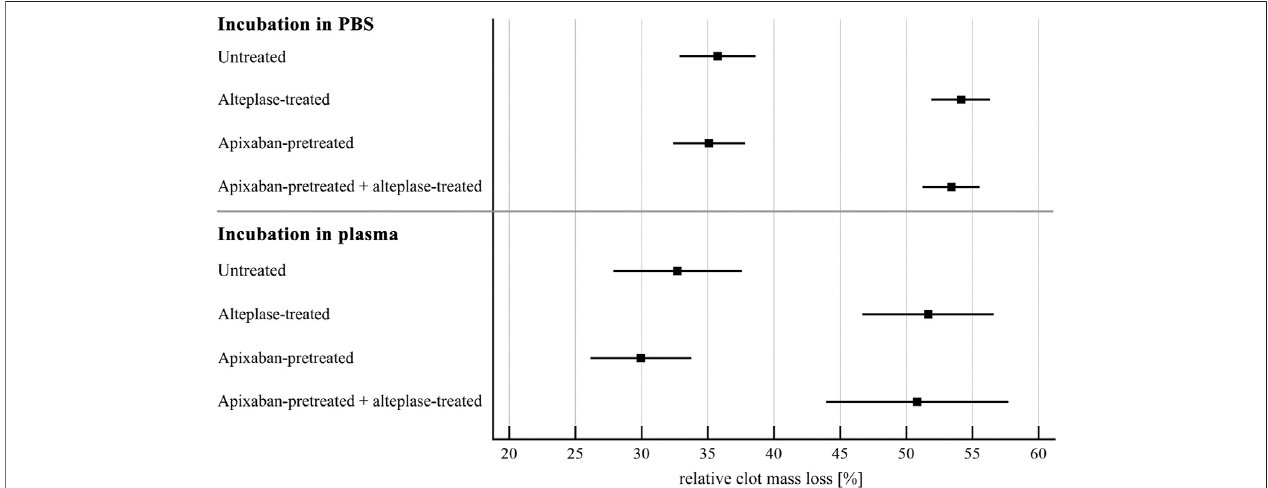
FIGURE 1 | Static model: clot lysis expressed as relative clot mass loss. The forest plot shows mean values (square) and 95% con fi dence interval (whiskers). n (cid:1) 54 – 57 for incubation in PBS and 12 – 15 for incubation in plasma. Results demonstrate that alteplase treatment provided ef fi cient thrombolysis, e.g., documented as greater clot mass loss compared to untreated group in plasma (52 ± 9% vs. 33 ± 9%, p < 0.01). For clots with and without apixaban, alteplase-induced lysis did not differ, e.g., in plasma clot mass loss was 51 ± 11% vs. 52 ± 9%, p (cid:1) 1.00. See Supplementary Table S1 for more details.